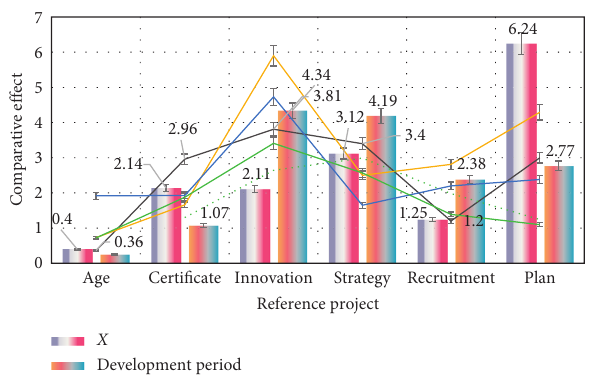
Figure 9: The relationship between company management and the quality of members.